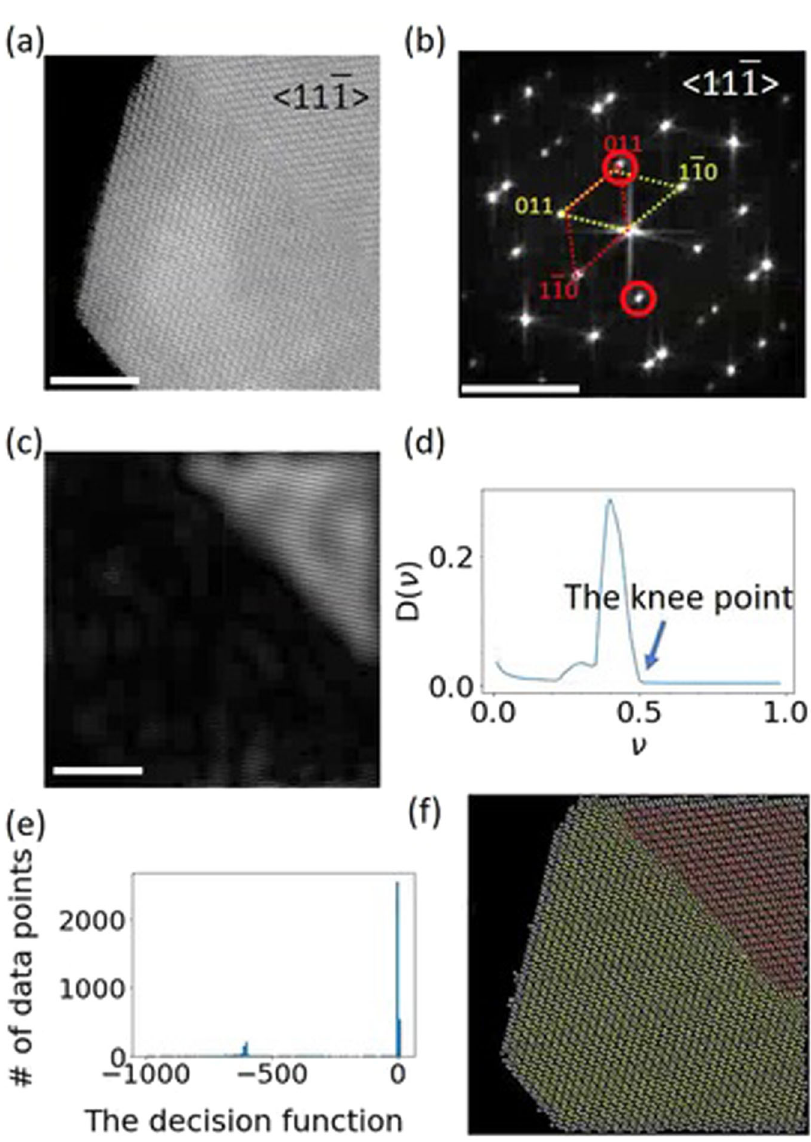
Fig. 4 Demonstration of detecting different domains separated by the twin boundary in a ZrO 2 nanoparticle. a A STEM image of ZrO 2 nanoparticle recorded at 100 kV. b FFT of atom-coordinate image of a . c Fourier fi ltered image formed by the IFFT from the circled spots in b which belong to one domain (in red coordinate in panel b ) but not the other (in yellow coordinate). d Optimized ν is selected from knee point of D ð ν Þ curve. e Two separated clusters of data points are detected using OCSVM with optimized ν parameter. f Two classes of data points in e are mapped onto atom-coordinate image with two different colors. Each color corresponds to a single domain; boundary between colors is the detected twin boundary. The scale bars in ( a, c ) represent 3 nm, and the scale bar in panel b represents 1/nm. P a nel a is adapted with permission from ref. 38 , © 2021 The authors.